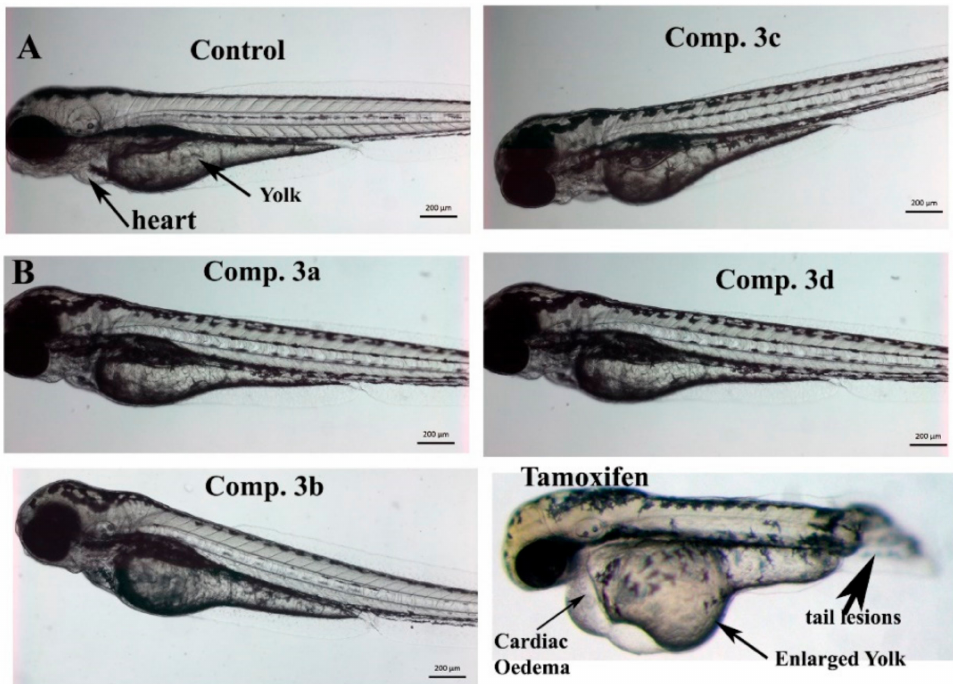
Figure 6. Representative images of the zebrafish embryos 48 hpf ( A ) control or ( B ) treated. Zebrafish embryos shown are treated with 1 mM of compounds 3a, 3b, 3c, 3d, and 10 µ M